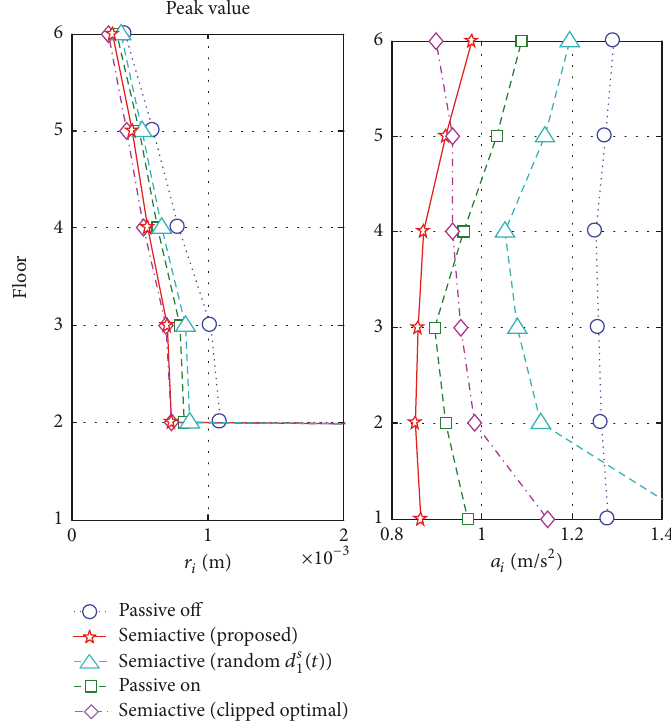
Figure 20: Simulation results for the Taft NS (1952) earthquake disturbance; Peak values of the relative displacement between neighboring floors and absolute acceleration of each floor.